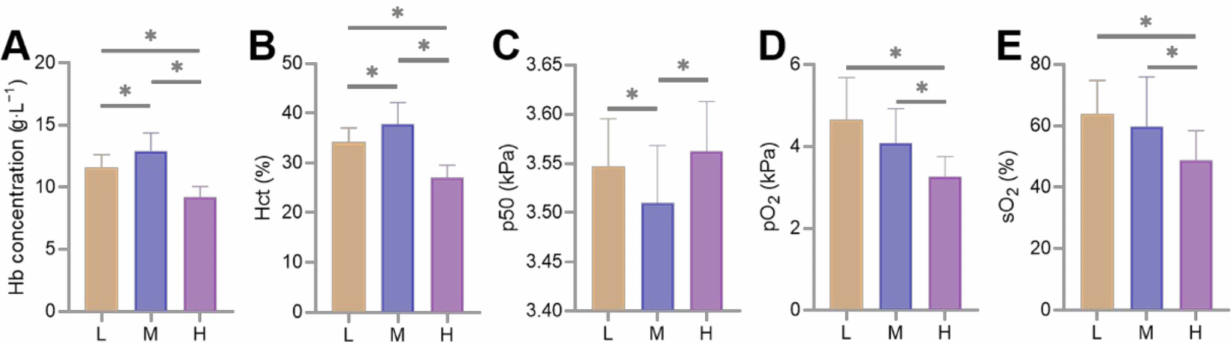
Figure 2. Differences in blood-gas indicators of Tibetan sheep at low (L), middle (M), and high (H) altitudes, * indicates significant differences between different altitudes ( p < 0.05). Hemoglobin (Hb) concentration ( A ), Hematocrit (Hct) ( B ), Half-saturation oxygen partial pressure (p50) ( C ), Partial pressure of oxygen (pO 2 ) ( D ) and Oxygen saturation (sO 2 ) ( E ) are shown.